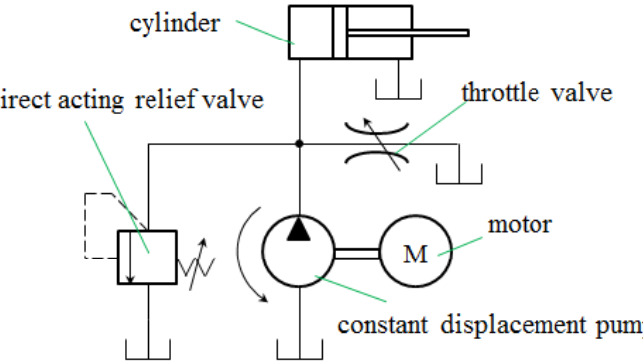
Figure 2. The parallel throttling speed-control circuit with constant displacement pump.